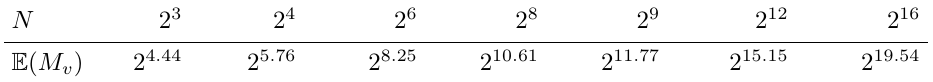
Table 8: Average numbers of valid signatures to cover various layers of N signatures. N 2 3 E ( M v